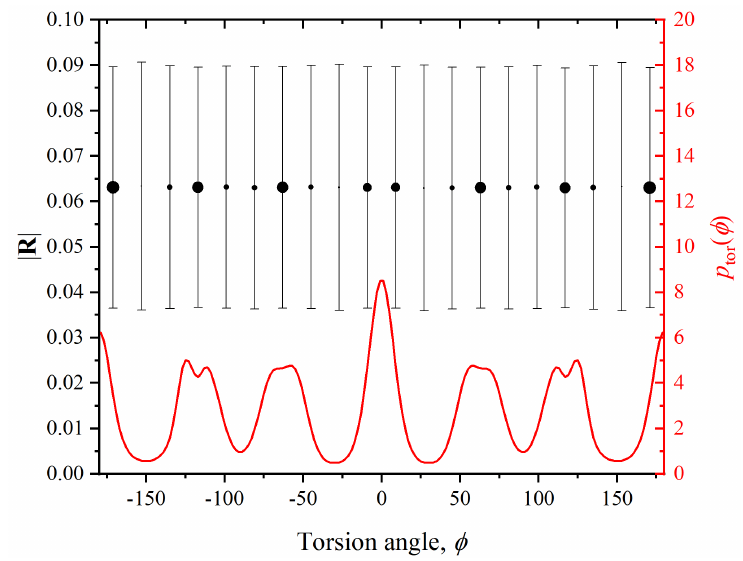
Figure 2. Left y -axis (black color): Distance | R | between a monomer and the centroid of its Voronoi cell, versus one of the torsion angles φ which belong to the same monomer, averaged over all frames in Region IV. Symbol size is proportional to the frequency of occurrence of the corresponding torsion angle φ . Right y -axis (red color): the probability distribution of torsion angles. Error bars are fluctuation amplitudes, angles have been grouped in 20 bins.